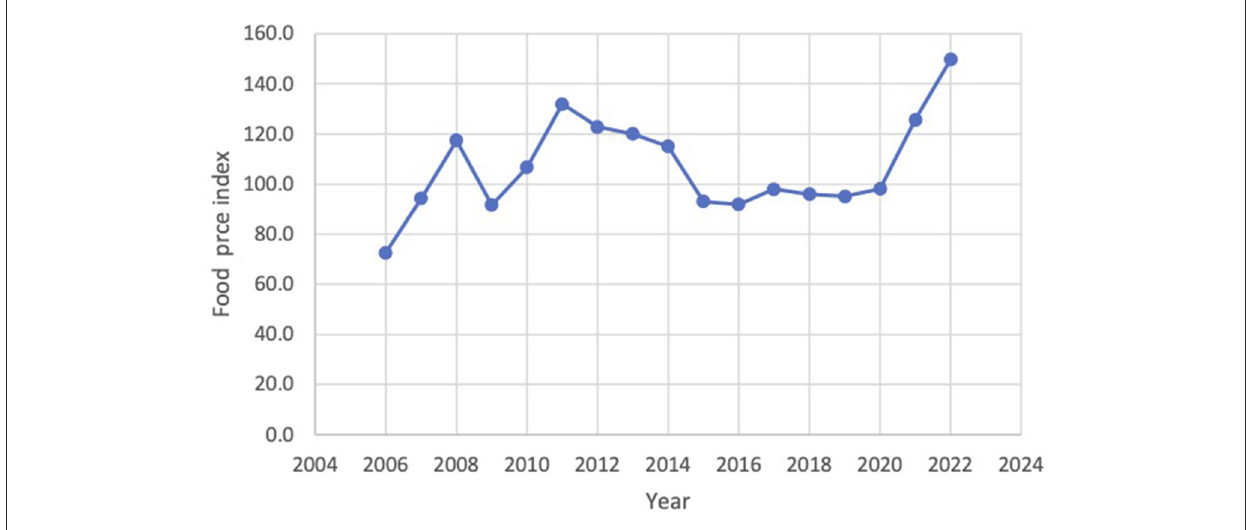
FIGURE3 Annual FAO food price indices from 2006–2022 (FAO,